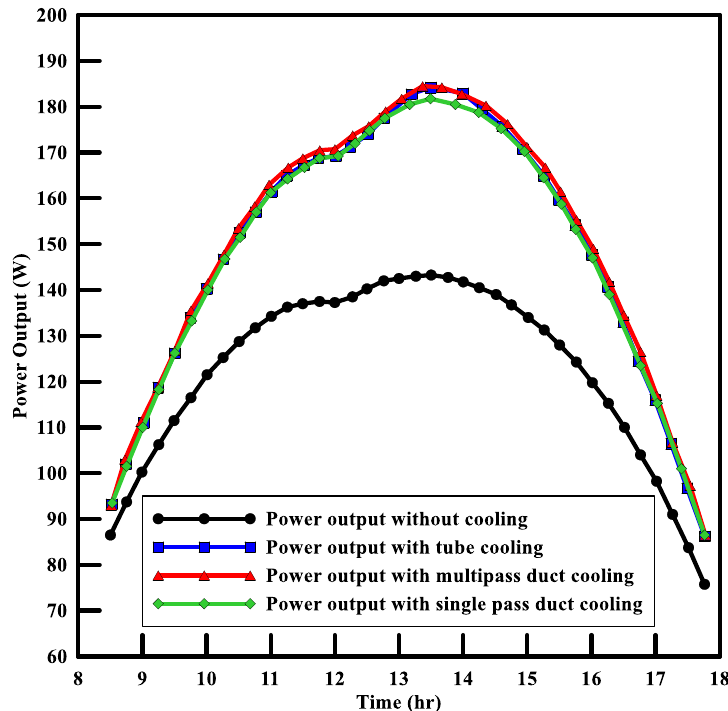
Figure 7. The power output of solar panels over the whole day for 9th of June.